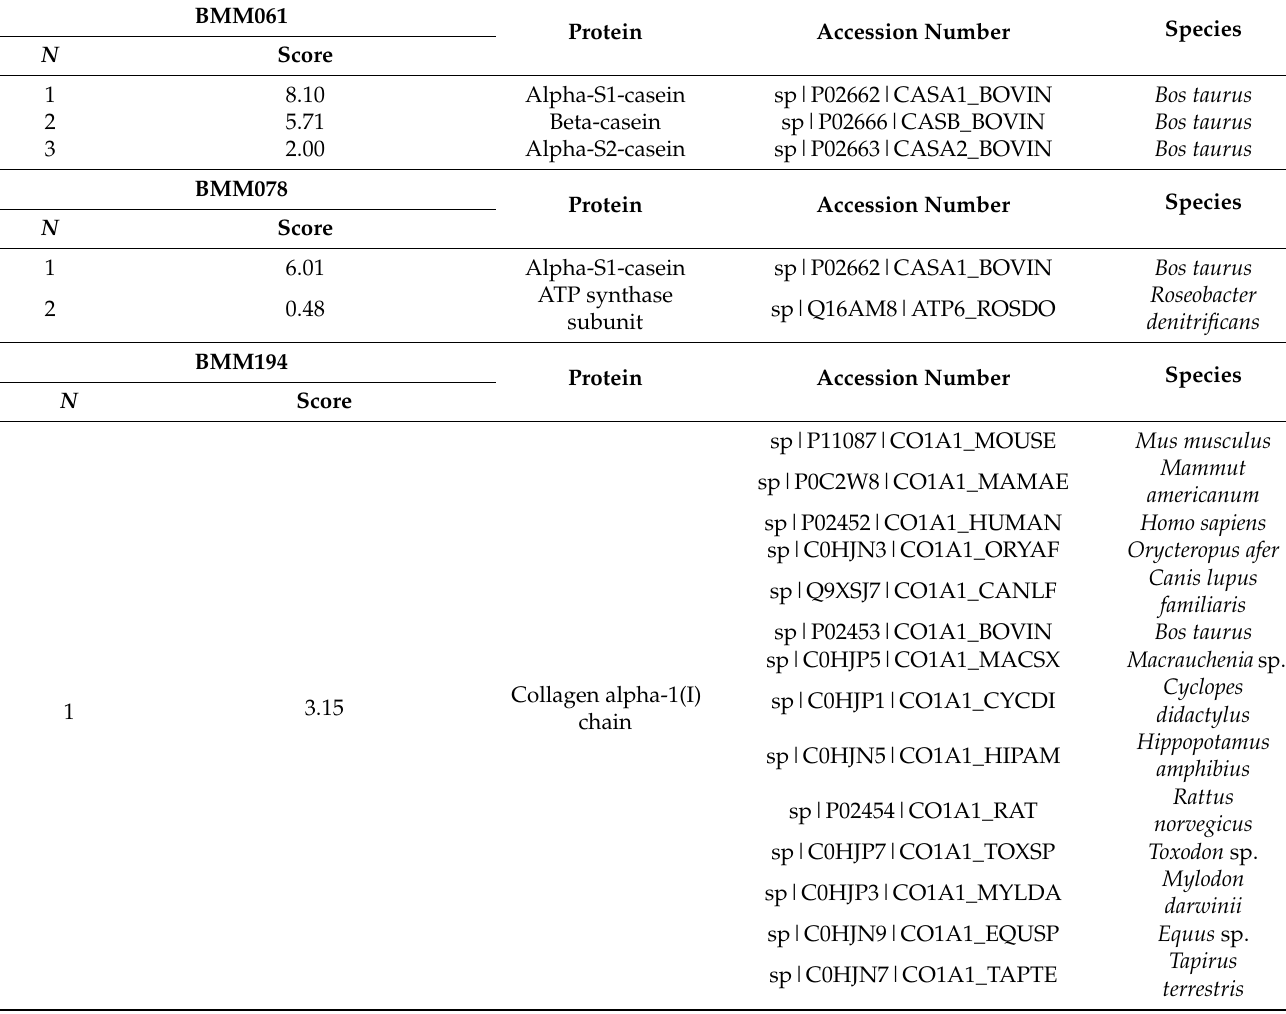
Table 8. List of marker peptides for animal species identification and the results of BMM194.